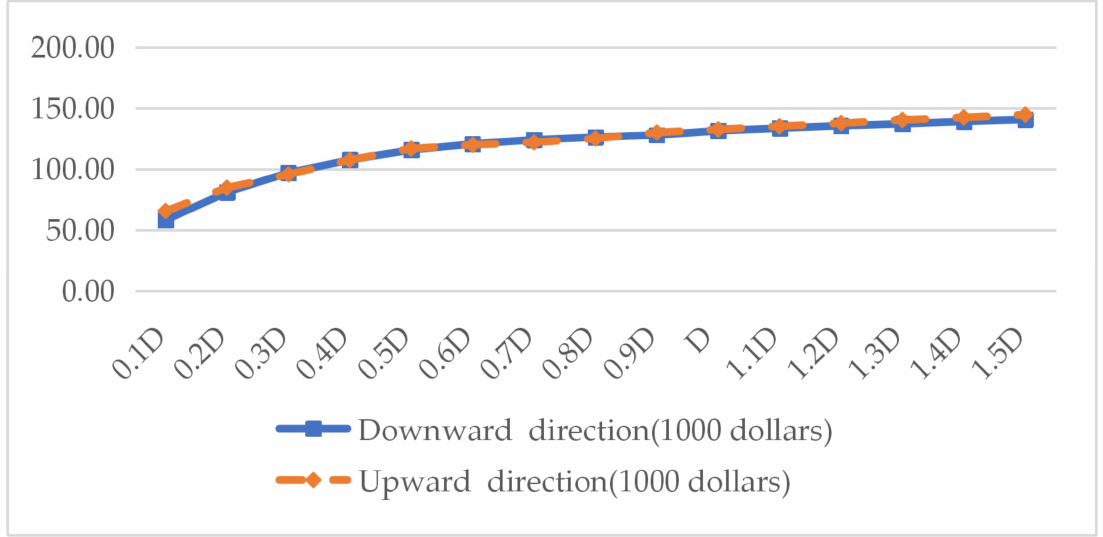
Figure 4. Impact of rapid freight demand change on optimal